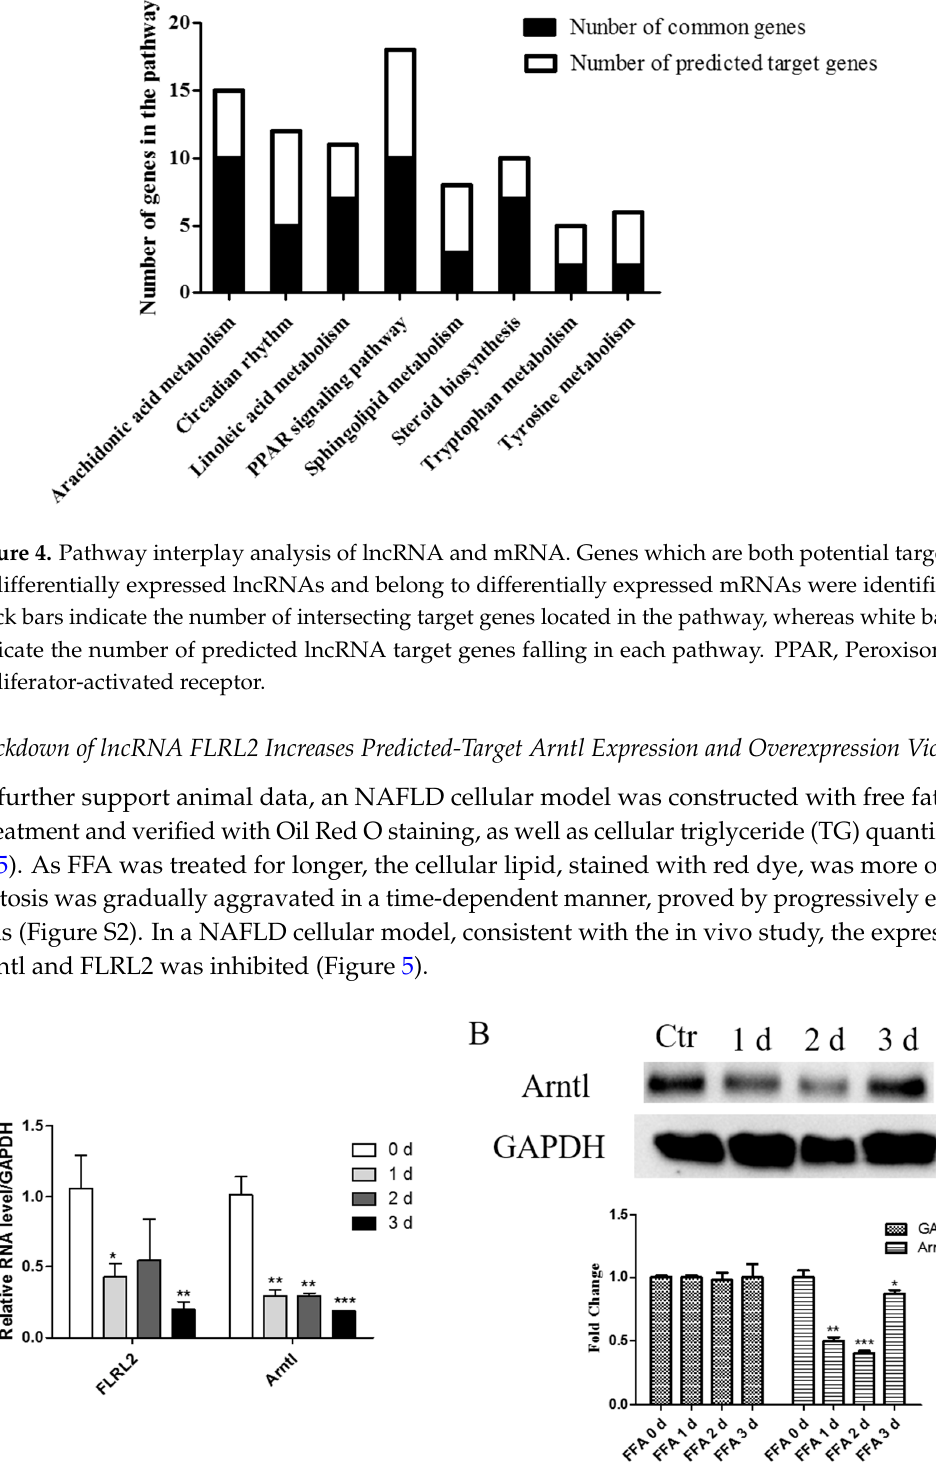
Figure 5. Decreased expression of fatty liver related lncRNA 2 (FLRL2) and aryl hydrocarbon receptor nuclear translocator-like (Arntl) in NAFLD cellular model. AML12 cells were treated with 1 mM free fatty acids (FFAs) for 1, 2, and 3 days (d) or 5% bovine serum albumin (BSA) as control. Cell extracts of total RNA ( A ) and protein ( B ) were collected and then tested accordingly. Expression of Arntl and FLRL2 were normalized to glyceraldehyde 3-phosphate dehydrogenase (GAPDH) in qPCR analysis. Data are presented as the mean ± SD.* p < 0.05; ** p < 0.01; *** p < 0.001.